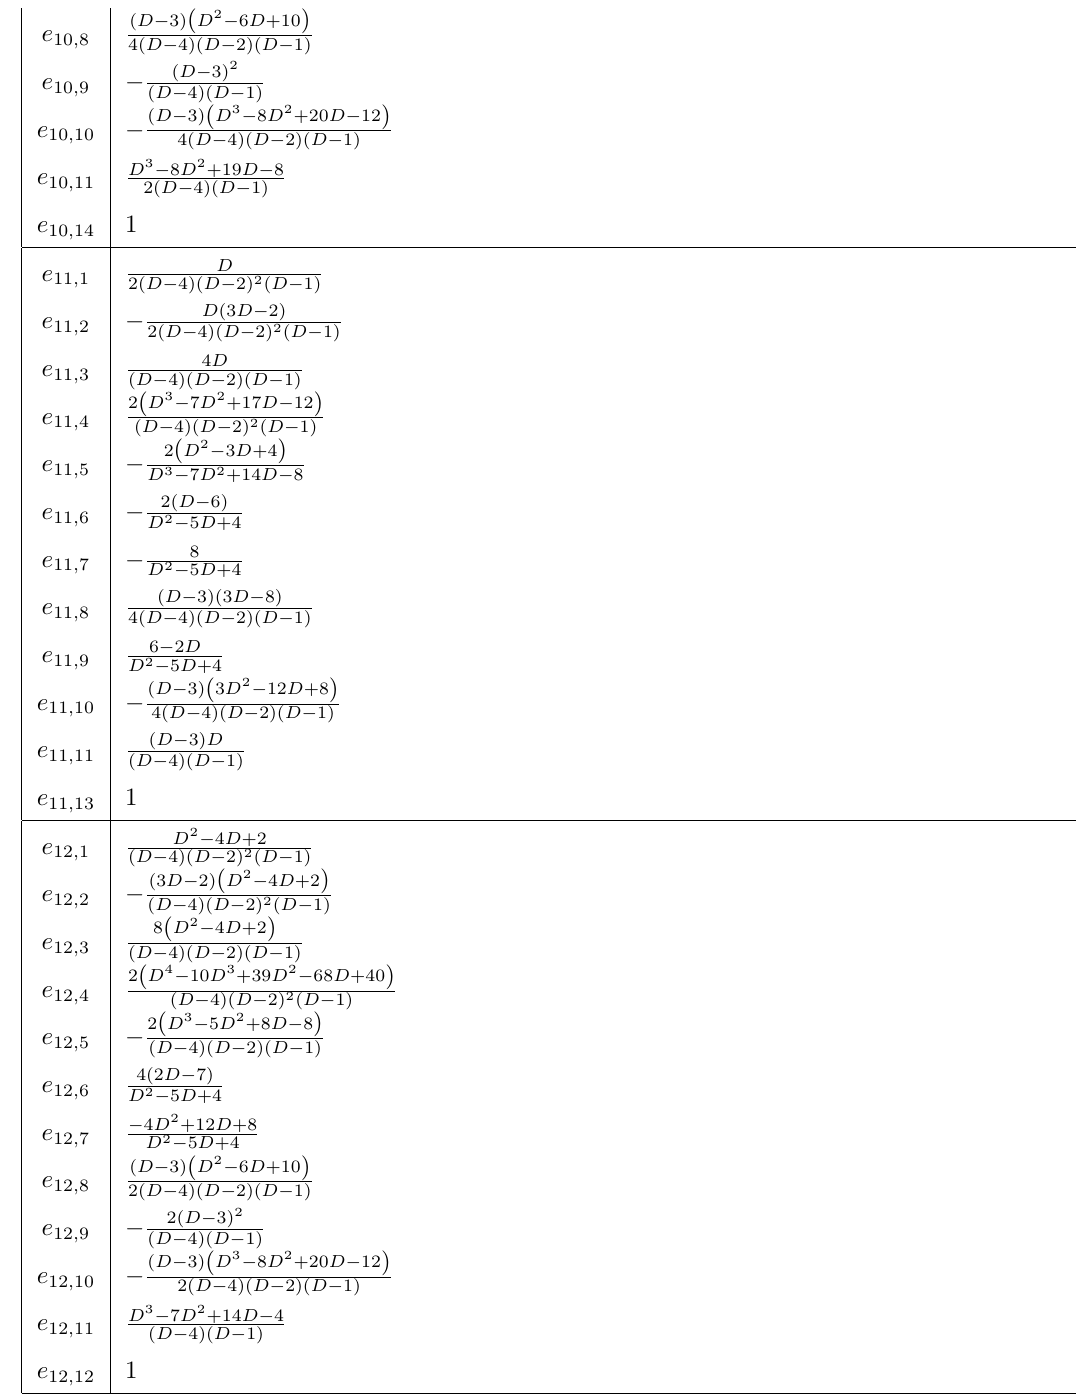
Table 2. Coefficients of dimension-generic quartic ETQT gravity solutions. Zero coefficients are